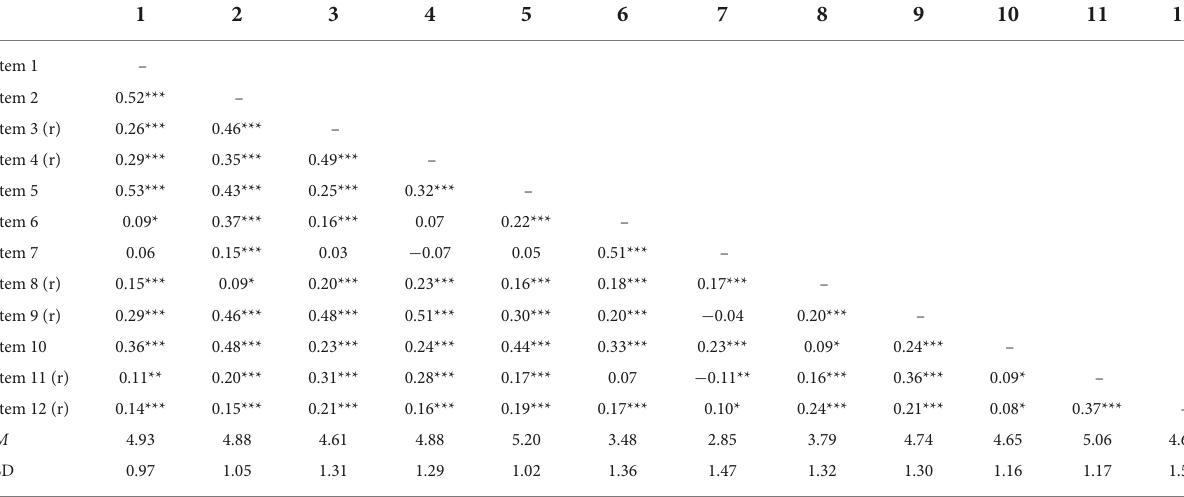
TABLE 1 Descriptive statistics and correlation matrix for Collective Efficacy Scale Short-Form (CES-SF) ( n =